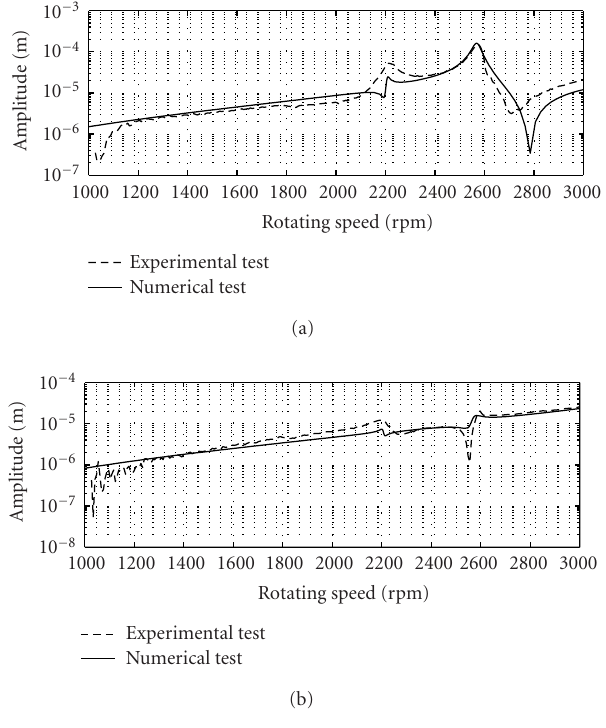
Figure 21: Comparisons between the numerical and experimen- tal responses at the two bearing supports. (a) Bearing support no.